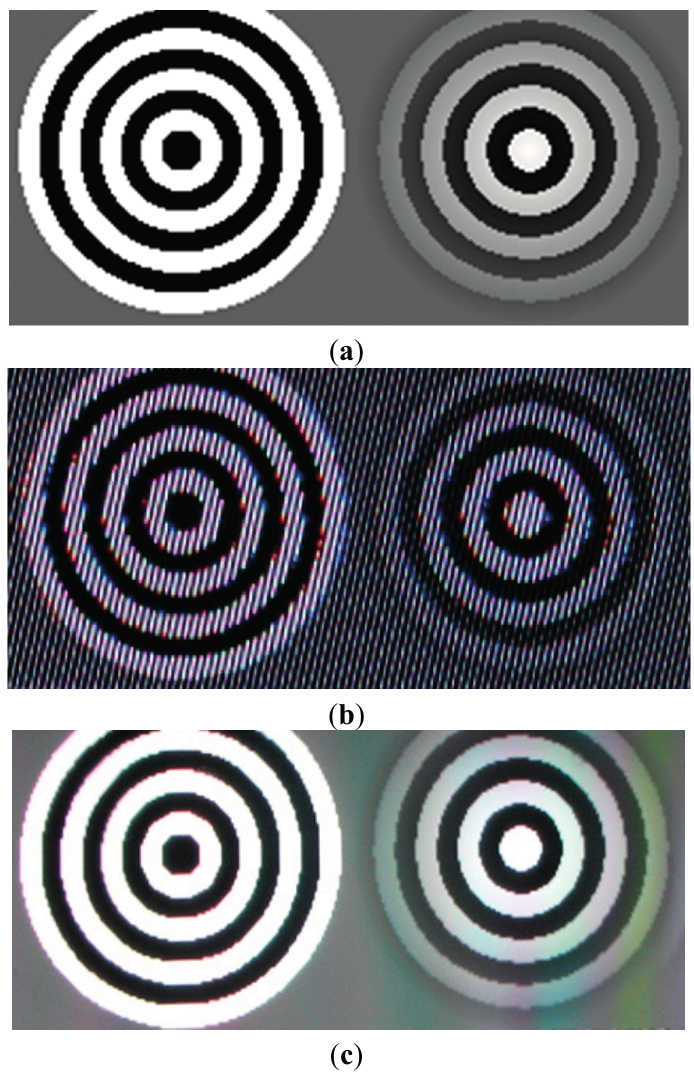
Figure 2. Light field and multiview autostereoscopic display comparison ( a ) Original 2D input patterns; ( b ) Screen shot of multiview autostereoscopic display; ( c ) Screen shot of projection-based light field